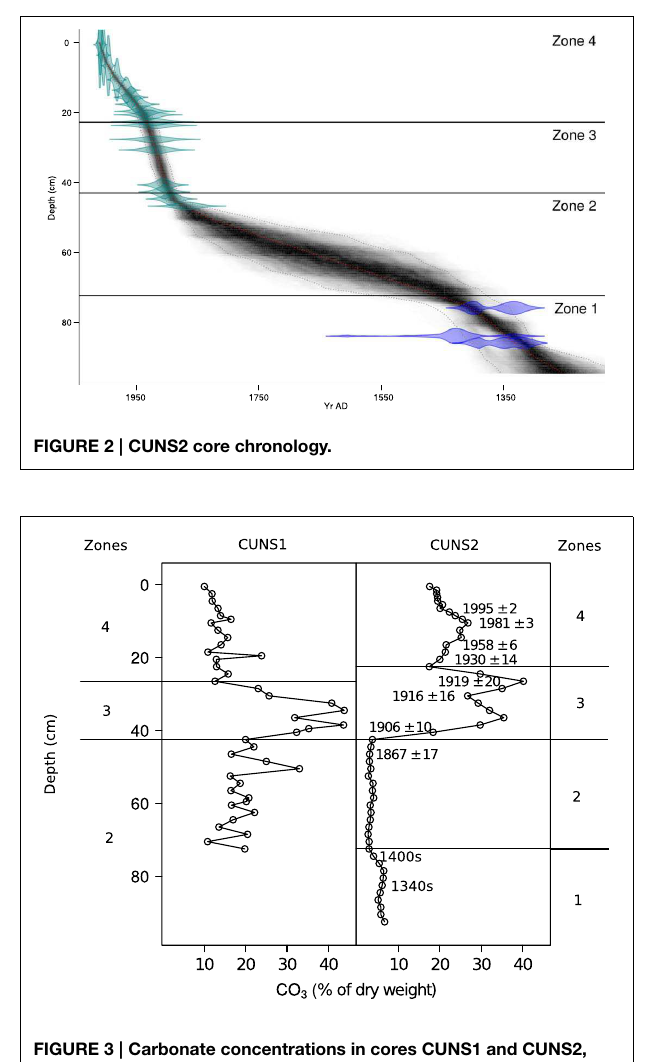
and SRs (ca. 0.2–0.5 cm year − 1 ) occurred in Zone 4 from